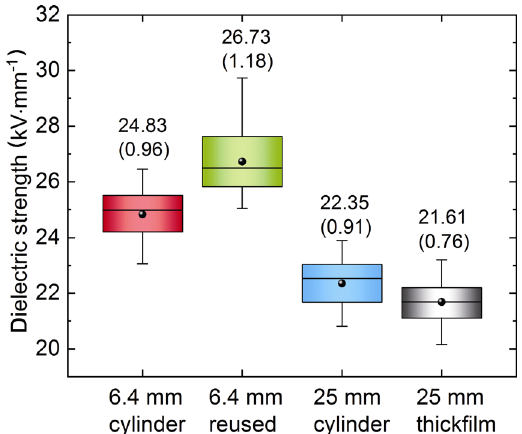
Fig. 6 Normal probability grid plot of dielectric strength (AC) of 620 µm Al 2 O 3 .